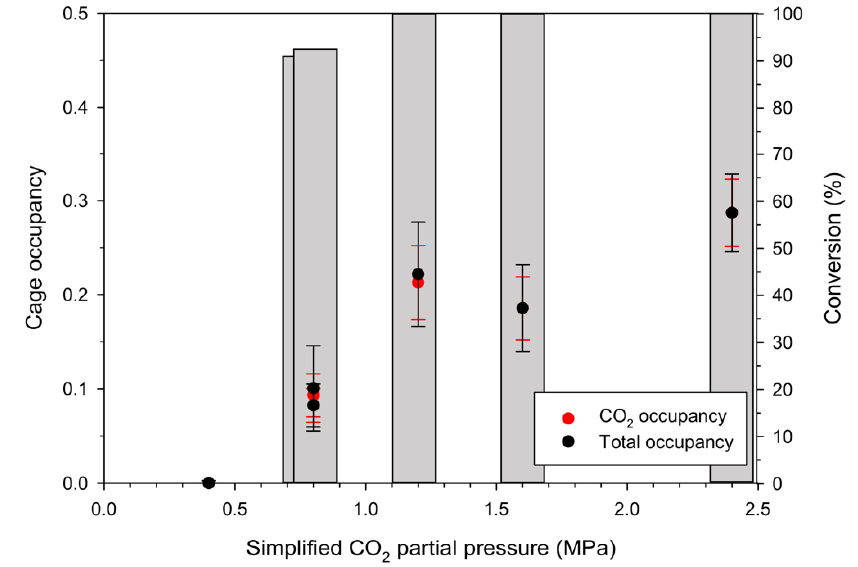
Figure 5. Cage occupancies of CO 2 and (CO 2 + CO) total molecules in the hydroquinone (HQ) clathrate cages, which are expressed regarding the simplified CO 2 partial pressures. Conversion yields of HQ to the clathrate form are displayed in the bar graph, with corresponding values shown in the right axis. Table 1. Cage occupancies of enclathrated guest molecules in the hydroquinone (HQ) clathrate cages and conversion yields of HQ to the clathrate form.